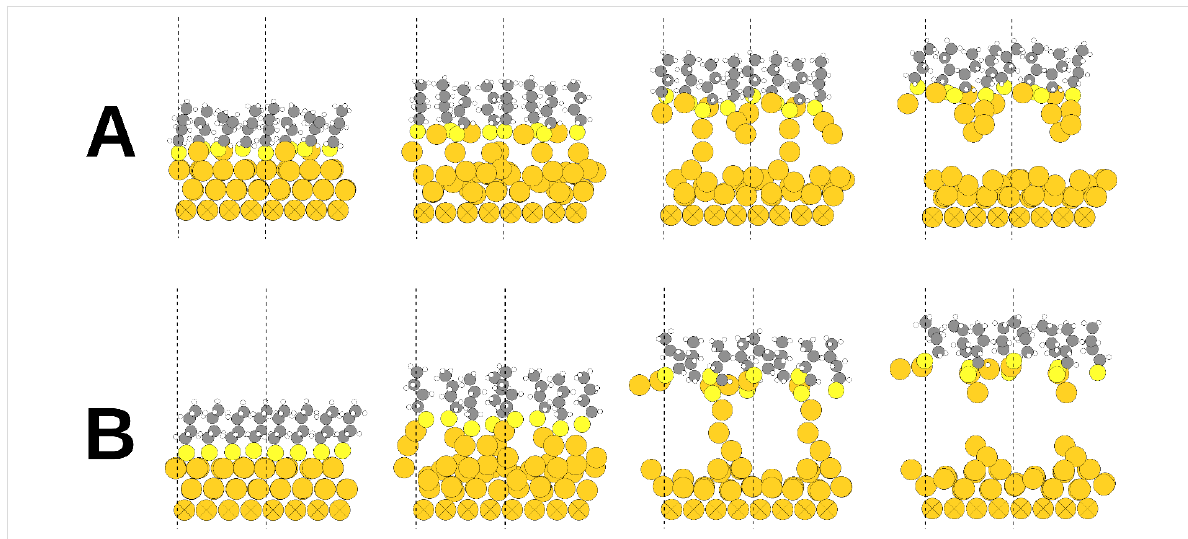
Figure 5: Two configurations calculated by molecular dynamics simulations of lift-off of a butanethiolate SAM on Au{111}. (A) Initially, densely packed RS–Au–SR (R = butyl) units occur on Au{111} having surface vacancies. The number of vacancies equals the number of RS–Au–SR units. (B) Initially, a dense packing of individual butane thiolates occurs at the face-centered cubic sites of a defect-free Au{111} surface. The dashed vertical lines define the borders of each computational unit cell, i.e., in the figure there are two unit cells side by side in each configuration. Atom colors: hydrogen (white); carbon (gray); sulfur (yellow); Au